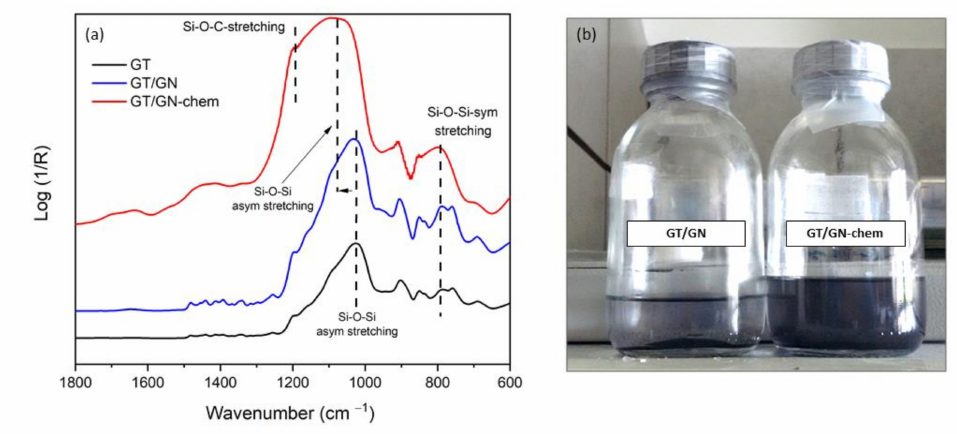
Figure 2. FTIR spectra of 3-glycidoxypropyl-trimethoxysilane (GPTMS)-tetraethyl-orthosilicate (TEOS) (GT), GT / GN and GT / GN-chem ( a ) and visual image of the stability of GN and GN-chem nanosheets in GT sols after 72 h ( b